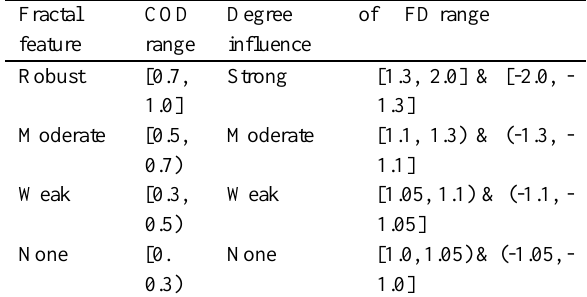
Table 1. Nominal categories of fractal feature and degree of influence of spatial scales on the landscape metric based on COD and FD (based on Feng and Liu, 2015)